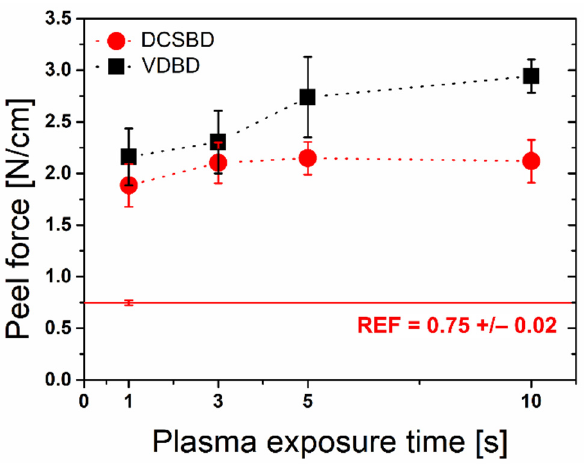
Figure 6. Development of the peel force of the BOPP surface after plasma treatment.